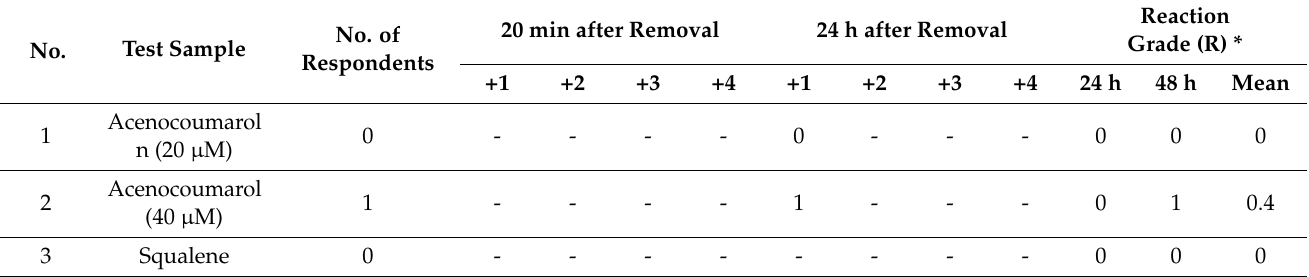
Table 1. The results from the primary human skin irritation tests ( n =